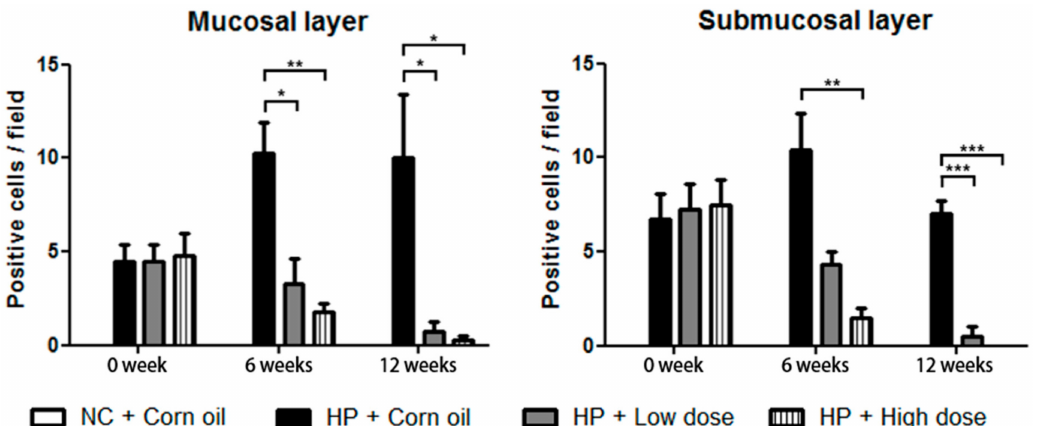
Figure 7. Immunohistochemistry of gastric mucosal and submucosal layer in H. pylori -infected Mongolian